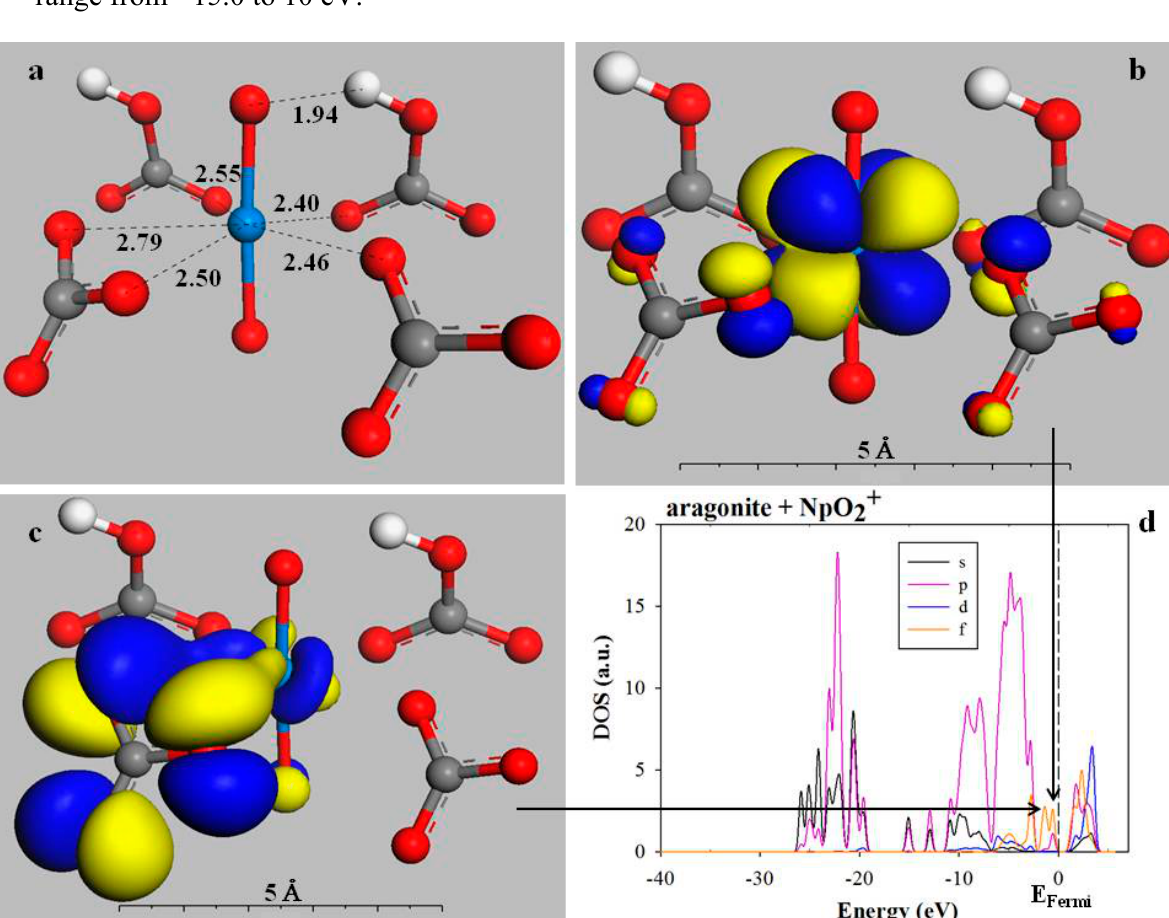
Figure 3. The coordination environment and electronic structure of neptunyl in aragonite. ( a ) Coordination environment of neptunyl with nearest-neighbor distances. One H + per unit cell is added to charge compensate the replacement of Ca 2+ by NpO 2+ The second H + ion comes from the adjacent unit cell (red = O, gray = C, white = H, blue = Np); ( b ) Wavefunction showing the non-bonding character of the HOMO (no overlap of the eight-lobed Np 5f and O 2p orbitals; ( c ) σ -bonding orbital ( E = 1.15 eV or 1.08 eV below EF) between Np 5f and O 2p orbitals from two O atoms of the same carbonate molecule (the other three σ